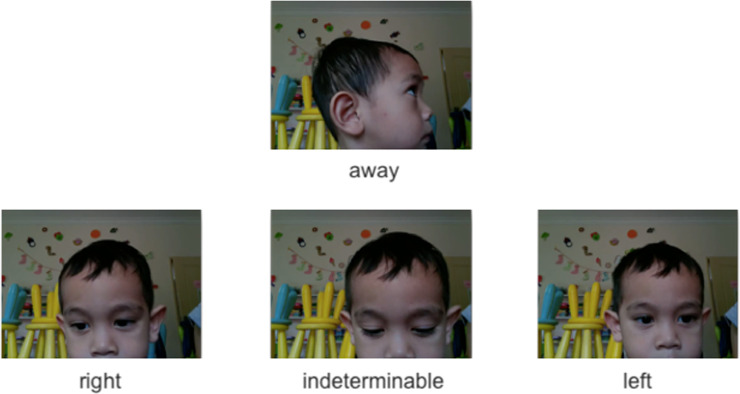
Video rating scale.Each video was split into 200 ms chunks and rated as either looking at the "left" or "right" (side of the screen), "indeterminable", or "away" (from the screen). Written consent for publication of the participating child’s pictures was obtained from the caregiver.